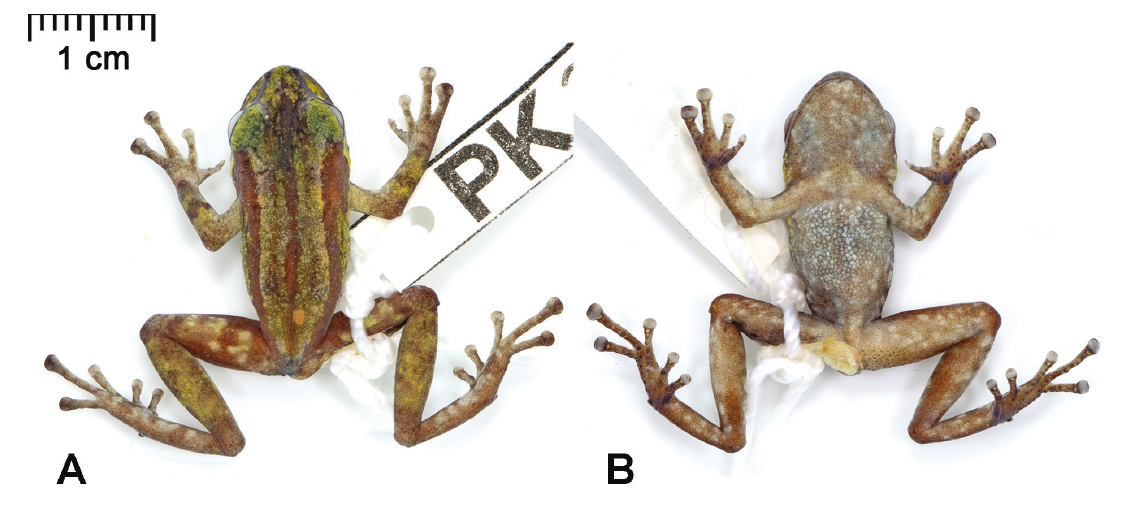
Fig. 10. Pristimantis imthurni sp. nov . in preservative. A . Dorsol view of the ♂ holotype (IRSNB 4165). B . Ventral view of the same specimen. Photographs by the